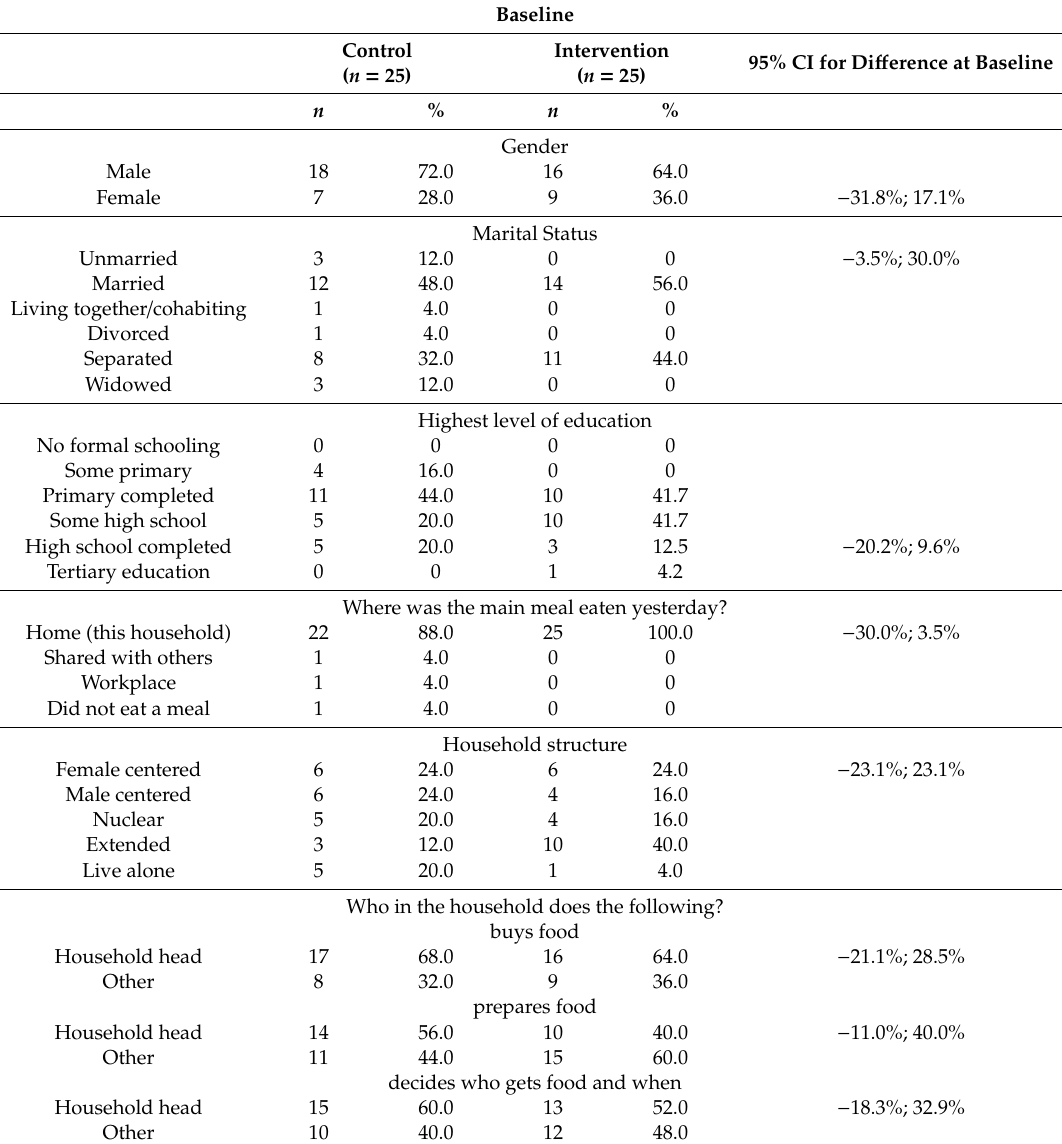
Table 1. Household demographics, responsibilities and structure of control and intervention groups at